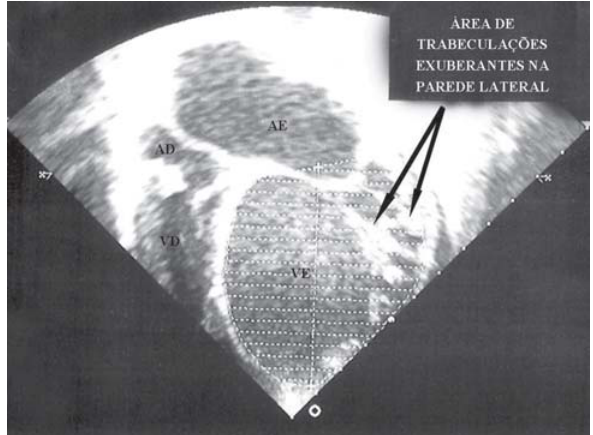
Fig. 4 – Ecocardiograma pré-operatório em corte apical evidenciando a importante dilatação das cavidades esquerdas e a área de trabeculações sugestiva de miocárdio não compactado na parede lateral do ventrículo